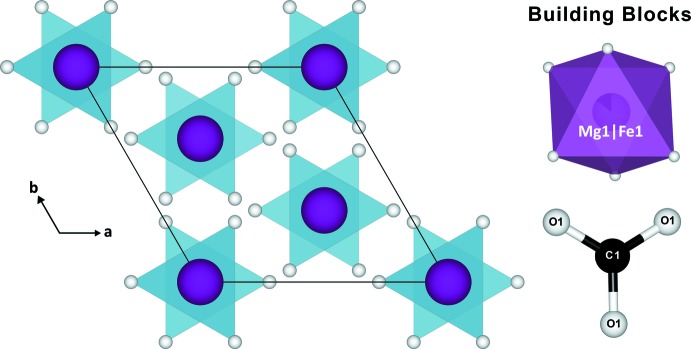
Crystal structure of (Mg0.85Fe0.15)CO3 at 98 GPa and prior to laser-heating shown in a projection along the c axis. The building blocks of the unit cell appear on the right. Here, iron occupies the same sites as the magnesium atoms.